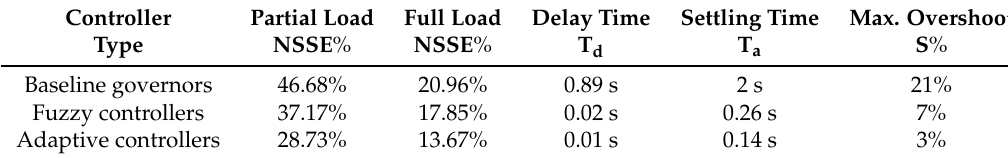
Table 4. Controllers in partial and load operations: T d , T a , S % and NSSE %